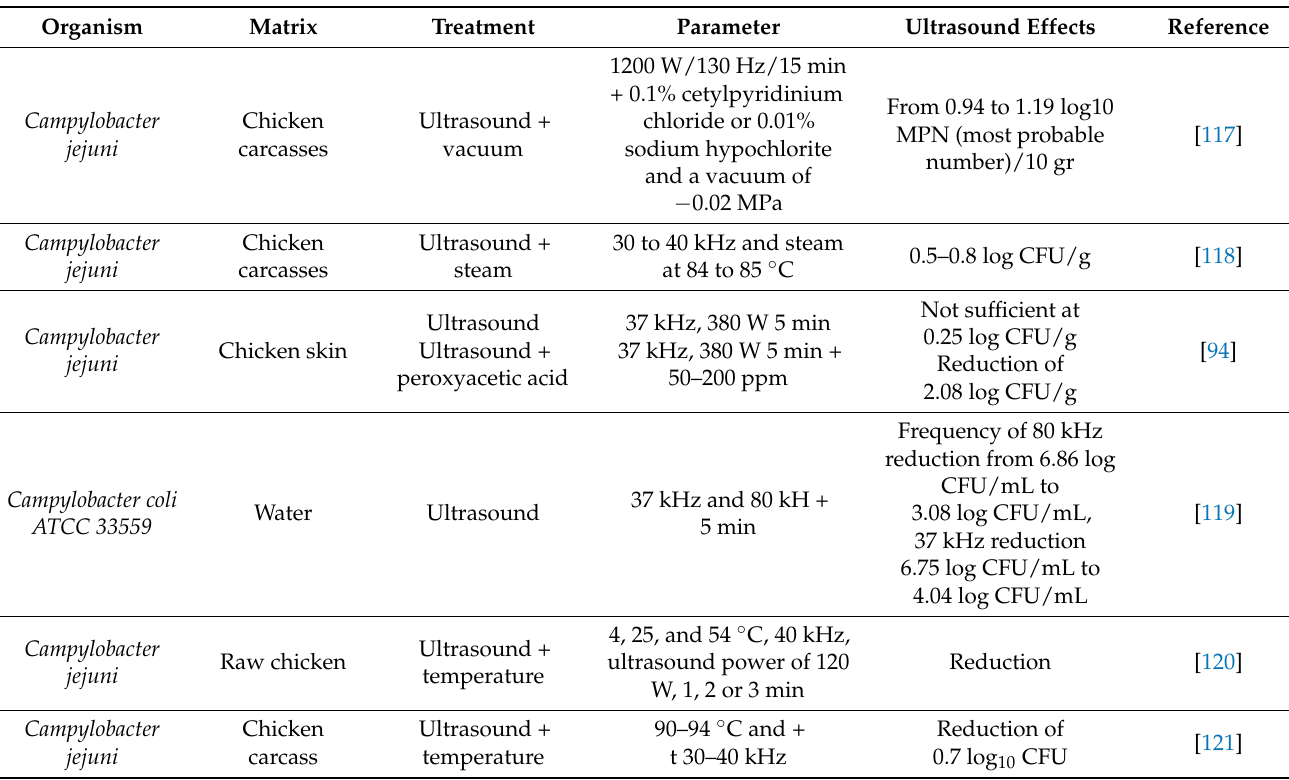
Table 6. Ultrasound effects as single or combined non-thermal technology: Campylobacter